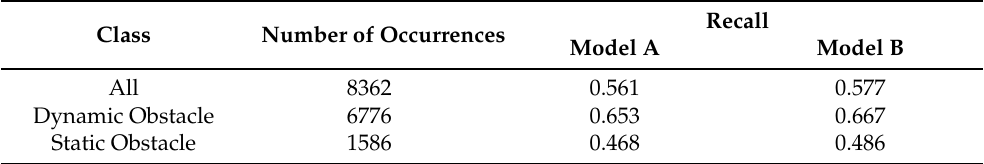
Table 4. Effect of simulated data addition on object detection. The model’s recall improved to 0.577 from 0.561, leading to a reduction in false positive